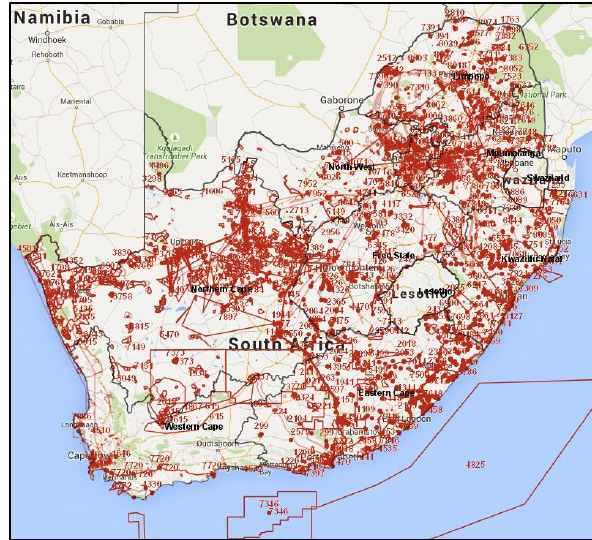
Figure 5: Development application map on